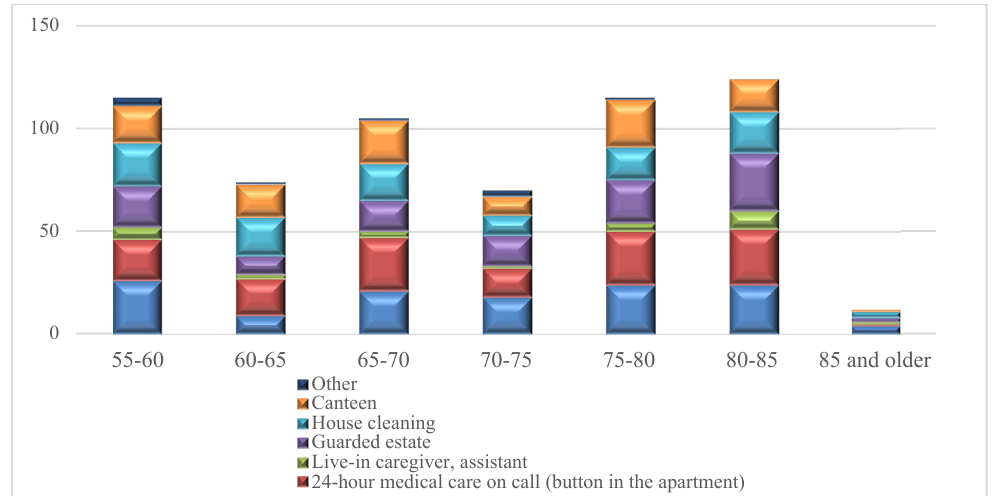
Figure 11. Facilities at a senior housing estate preferred by the respondents by age (number of indications).